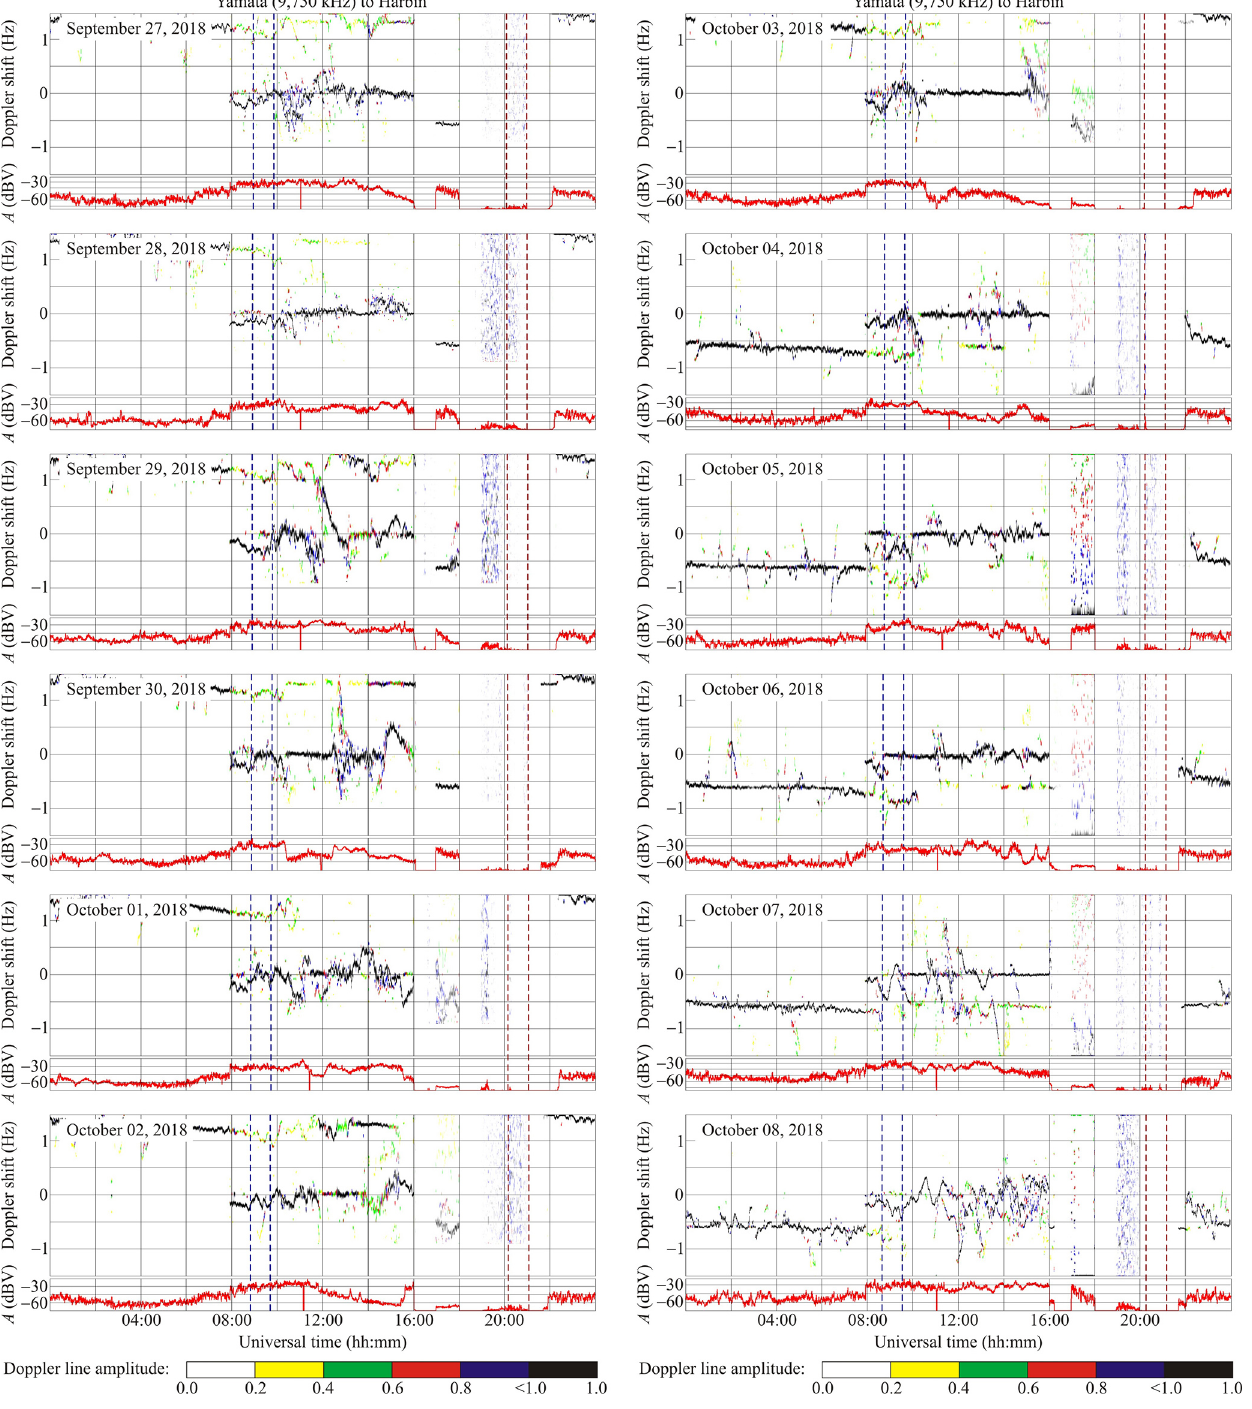
Figure 13. Same as in Fig. 6 but for the Yamata to Harbin radio-wave propagation path at 9750kHz for the 27 September–2 October and 3–8 October 2018